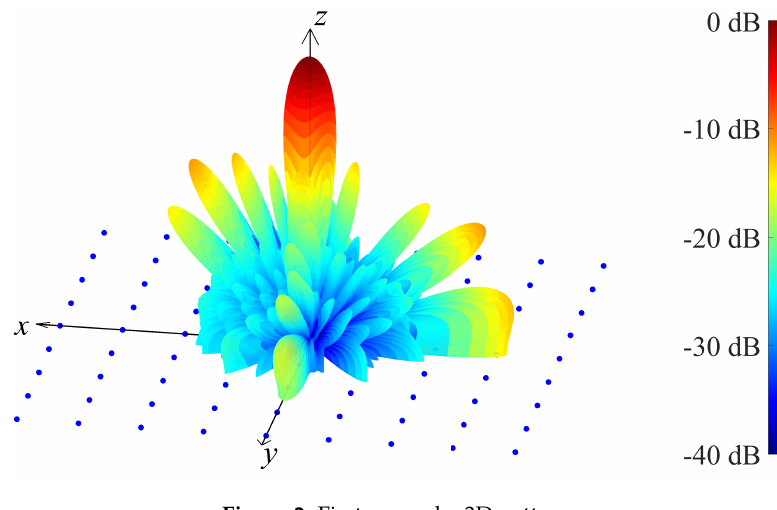
Figure 2. First example: 3D pattern.